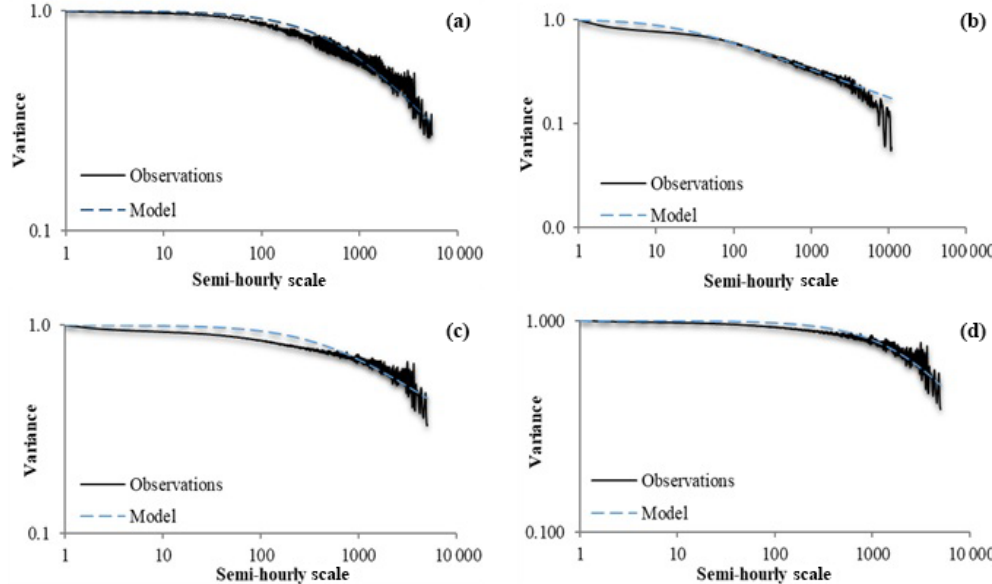
Figure 4. Climacogram for waves’ height (a) , direction (b) , peak period (c) and mean period (d) in Hilo, Hawaii.